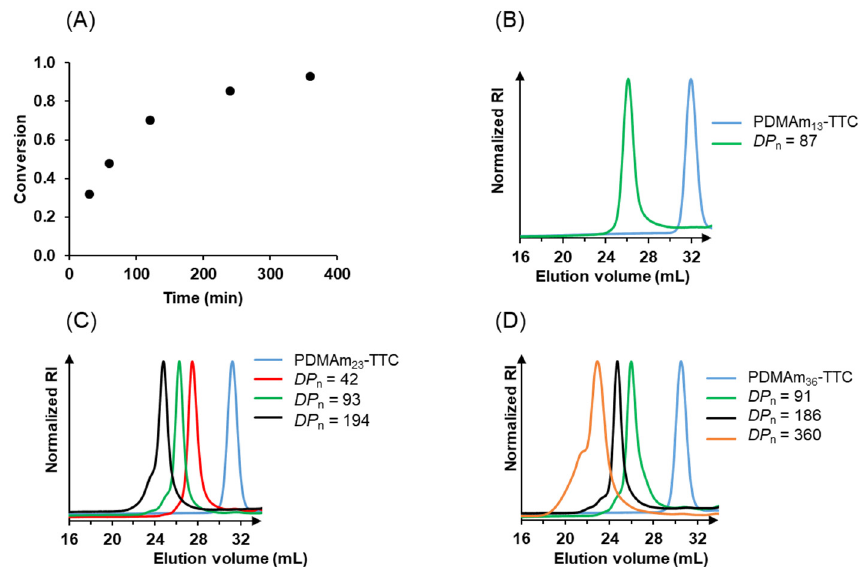
Figure 1. ( A ) Monomer conversion monitored by 1 H NMR in DMSO-d 6 for PDMAm 23 - b -PCMAm 93 ( Entry 3 , Table 1); Normalized size exclusion chromatograms of PDMAm macroRAFT agents and the resulting diblock copolymers using PDMAm macroRAFT agents of various DP n : ( B ) DP n = 13; ( C ) DP n = 23; ( D ) DP n = 36. The DP n reported in the figures is the DP n of the PCMAm block determined via the monomer conversion.